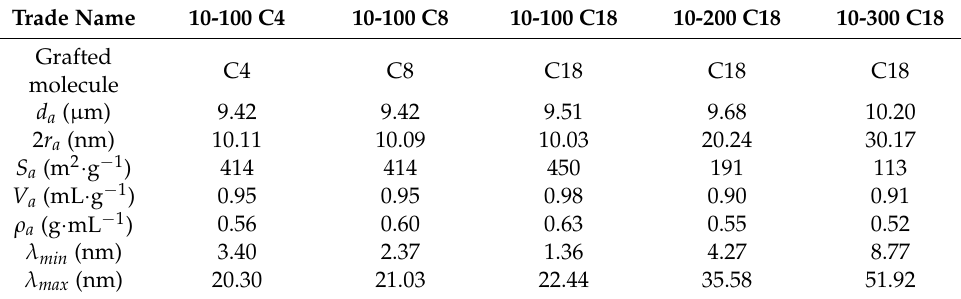
Table 1. Structural parameters of hydrophobic silica